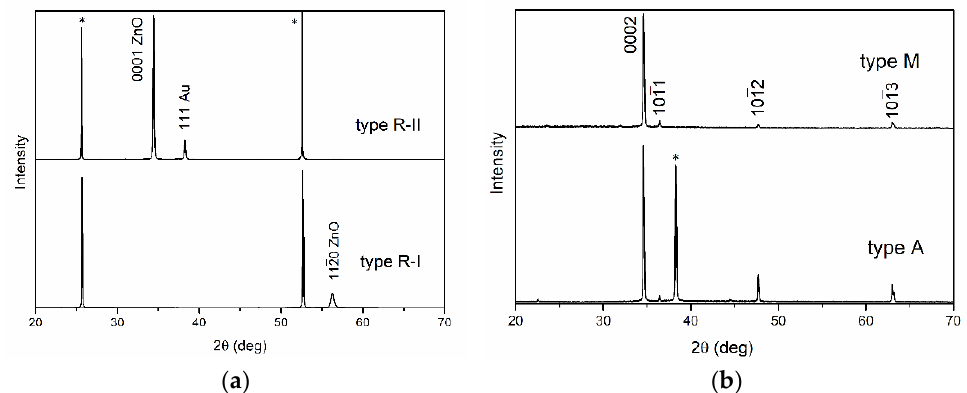
Figure 2. XRD patterns of ZnO films: ( a ) type R-I (bottom), type R-II (top); ( b ) type A (bottom), type M (top). Designation * denotes reflections of the sapphire substrate.